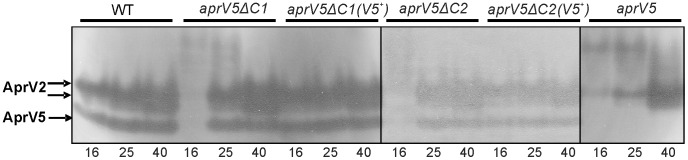
Extracellular protease zymograms of the aprV5 C-terminal deletion strains.Cultures from 16 h, 25 h and 40 h TAS broth cultures of the wild-type strain VCS1703A (WT), the aprV5Δ478–595 strain JIR3947 (aprV5ΔC1) and its complemented derivative JIR3968 (aprV5ΔC1(V5+)), the aprV5Δ503–595 strain JIR3956 (aprV5ΔC2) and its complemented derivative JIR3965 (aprV5ΔC2(V5+)) and the aprV5 mutant JIR3756 (aprV5) were examined. The profile of the aprV5Δ560–595 strain JIR3969 (aprV5ΔC3) is not shown but was identical to that of aprV5ΔC2.